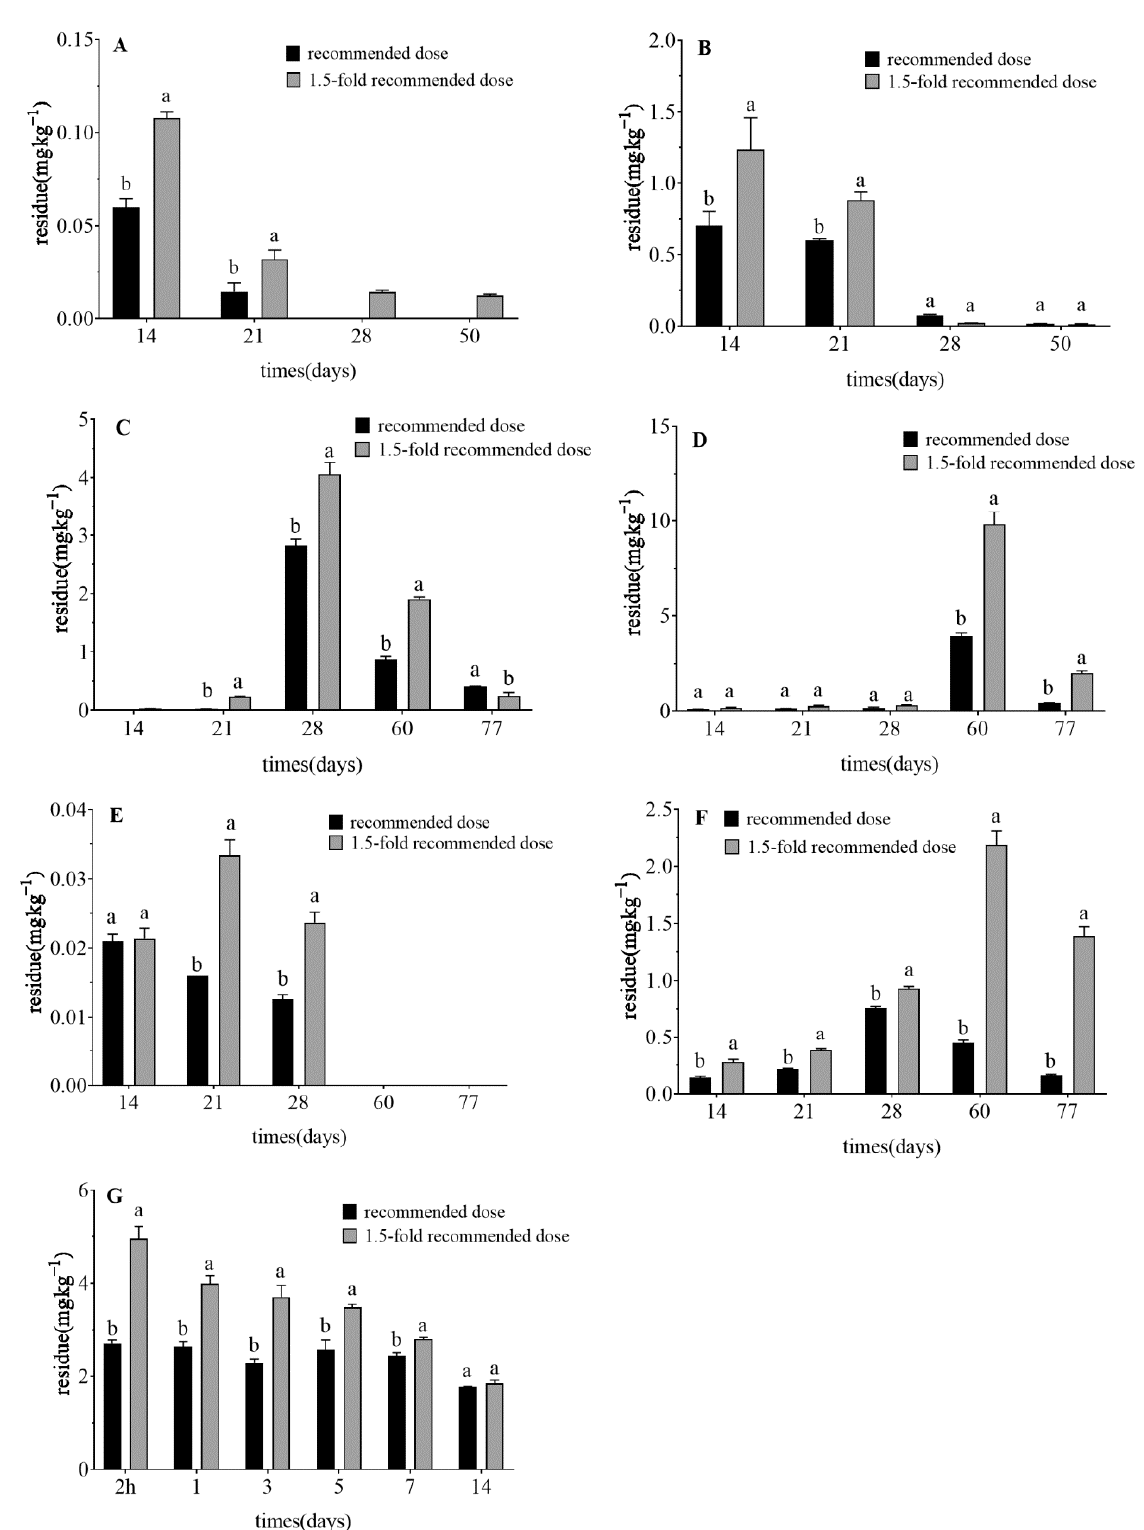
Figure 1. Dissipation rates of ( A ) clothianidin in celery, ( B ) clothianidin in soil, ( C ) imidacloprid in celery, ( D ) imidacloprid in soil, ( E ) abamectin in celery, ( F ) abamectin in soil, ( G ) chlorantraniliprole in celery after application of the pesticide at the recommended dose and 1.5-fold the recommended dose. Different letters across treatments indicate significant differences at p < 0.05.